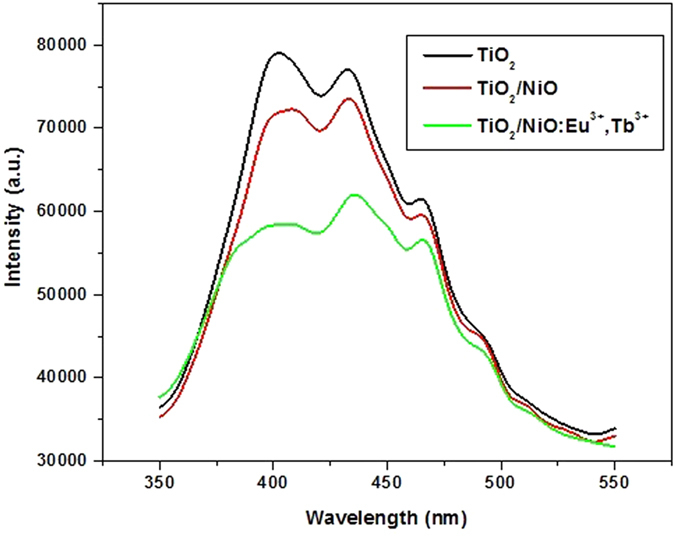
PL spectra of TiO2, TiO2/NiO and TiO2/NiO:Eu3+,Tb3+.